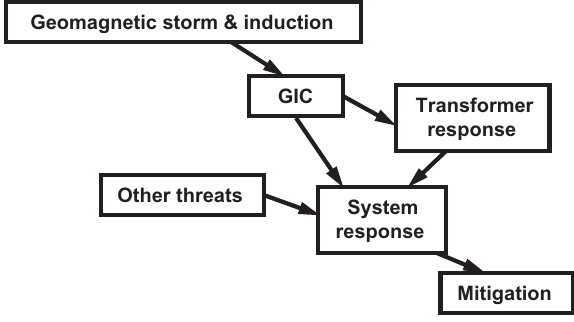
Fig. 1. Systems approach to GICs.